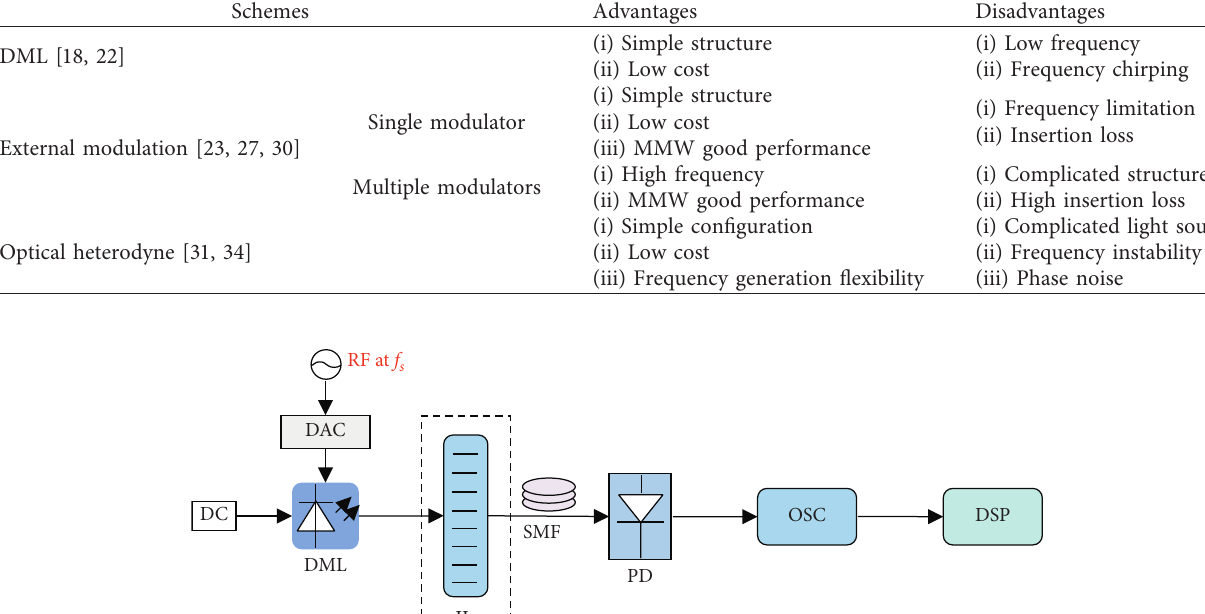
Table 2: Comparison of different mm-wave generation schemes [5].